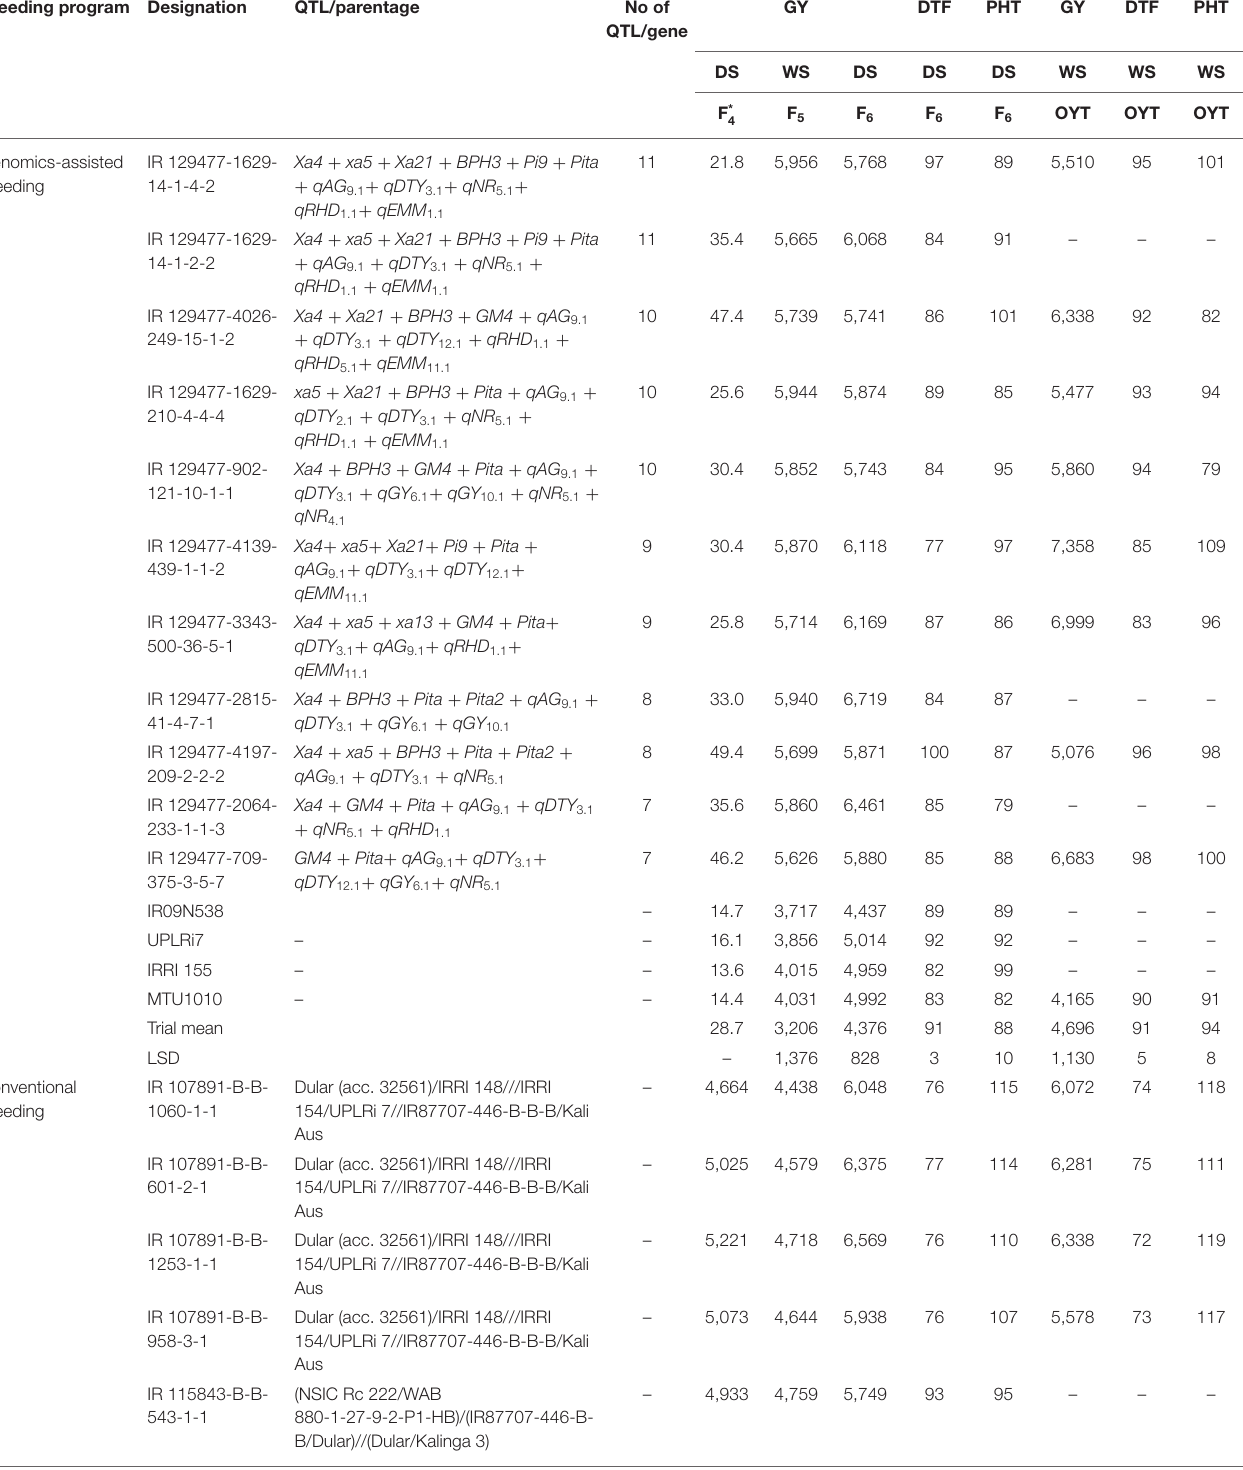
TABLE 7 | Mean comparison of grain yield (kg ha − 1 ), DTF (days), and PHT (cm) of breeding lines developed under the genomics-assisted breeding program and conventional breeding program. Breeding program